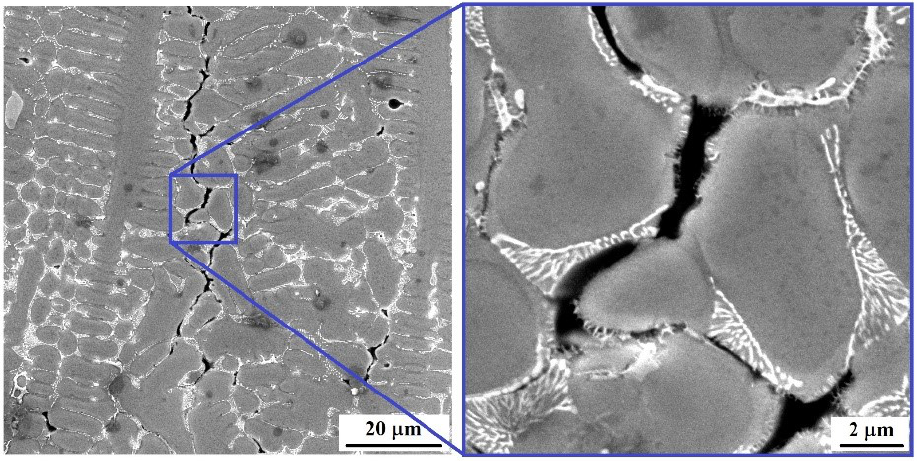
Figure 6. Microcracks formed by eutectic